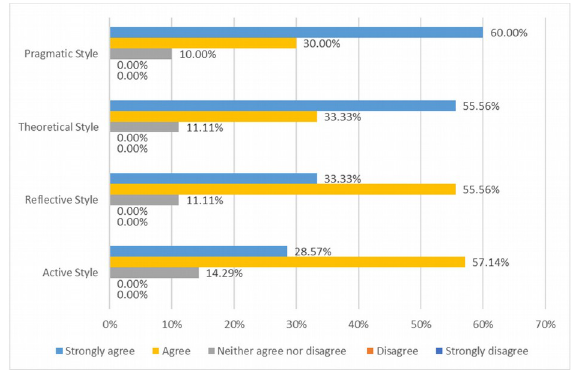
Figure 6. I can choose the type of materials that best suit